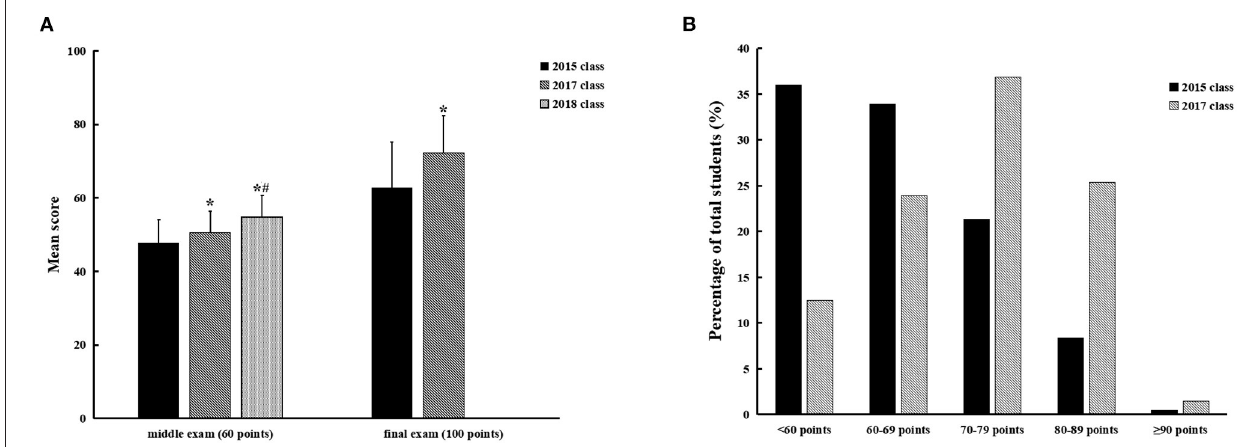
FIGURE 1 | Comparison of student achievement between traditional instruction and blended learning. (A) Average scores of the middle exam and final exam in the 2015 class ( n = 431), 2017 class ( n = 418) and 2018 class ( n = 586), analyzed by ANOVA, T -test and LSD. Values are means ± SD. * P < 0.001 vs. 2015 class without blended learning. # P < 0.001 vs. 2017 class. (B) Distribution of the final exam scores in the 2015 class ( n = 431) and 2017 class ( n = 418). The results were presented as percentage of total students of the class.